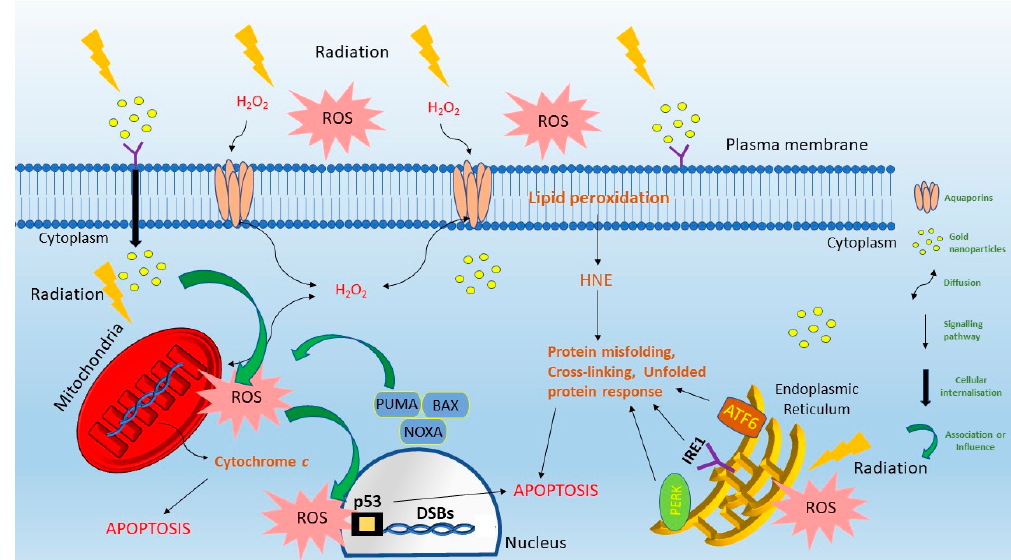
Figure 1. Mechanisms of ROS, generated during exposure to ionizing radiation, leading to apoptosis. Radiation and radiation induced ROS leads to lipid peroxidation. This damage is associated with permeability of cell membrane and disruption of transport of molecules across the membrane [31,39]. The poly unsaturated fatty acids of the lipid membrane when peroxidised leads to formation of 4- hydroxy-2-nonenal (HNE) which easily reacts with thiol or amino groups causing cross linking of proteins [31,40]. Greater levels of HNE also triggers unfolded protein response which in turn activates protein kinase R PERK ((PKR)-like endoplasmic reticulum kinase) [41]. This initialises certain transcription factors which trigger the JNK and p38 signalling pathways. This mode of action suggests that HNE might be an upstream regulator between ER stress and radiation induced ROS response [42]. ROS can also trigger sphingomyelinase catalysing hydrolysis of sphingomyelin in cell membranes. This induces production of ceramide [43]. DNA double strand breaks induced by radiation also activates ceramide synthase and is associated with both the intrinsic and extrinsic apoptotic pathways via other signalling cascades [44].